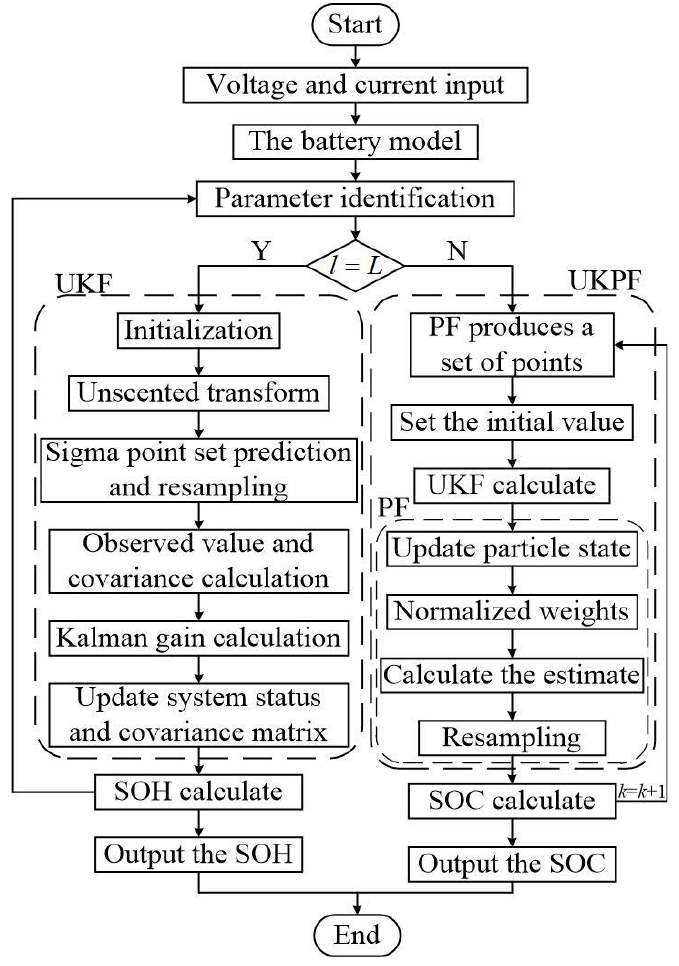
Figure 3. Flow chart of multi-time scale joint estimation method.